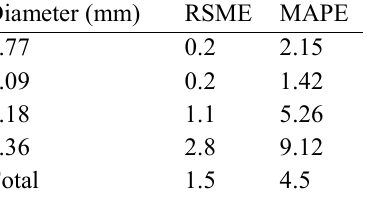
Table 3. Root-Mean-Square and mean absolute percentage errors in numerical model and experimental results Diameter (mm) RSME MAPE